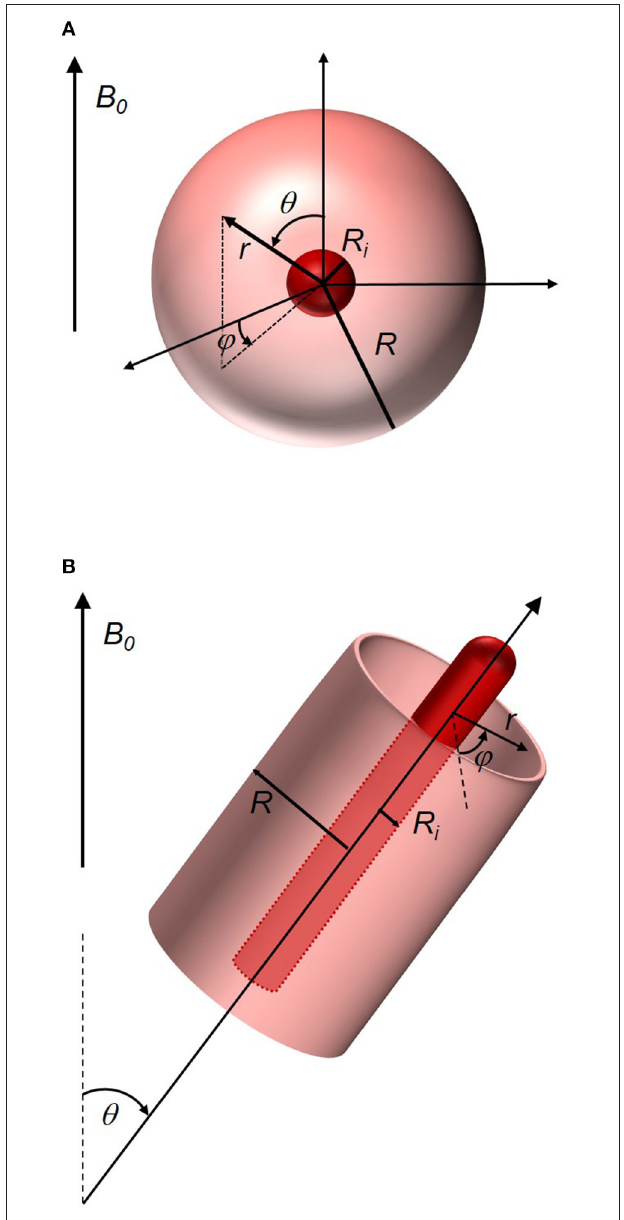
FIGURE 2 | Spherical and cylindrical object in an external static magnetic field B 0 . (A) Spherical magnetic object with radius R i (red), that is surrounded by a dephasing volume sphere with radius R . The corresponding local Larmor frequency can be found in Equation (7). (B) Cylindrical object (red) with radius R i of the cross section circle perpendicular to the cylinder axis. The cylinder is surrounded by a cylindrical dephasing volume with radius R . The angle θ between external magnetic field and cylinder axis is important in the determination of the local Lamor frequency in Equation (8).